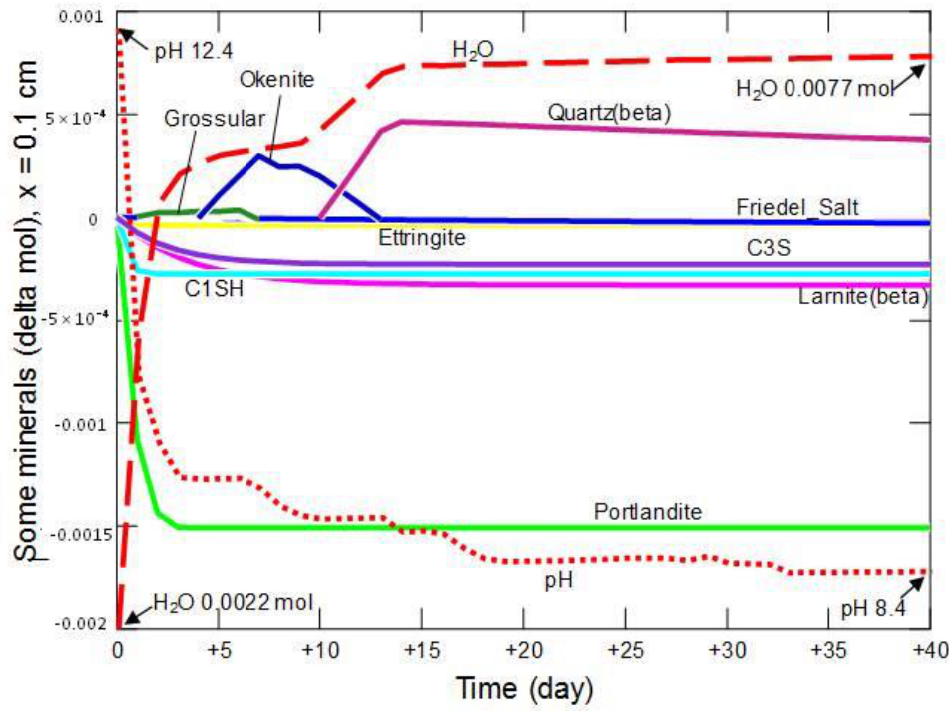
Figure 19. Changes in the amount of water, mineral phases and pH in the cement matrix at a distance of 0.1 cm from the beginning of the model domain, in conditions of ammonium chloride penetration.